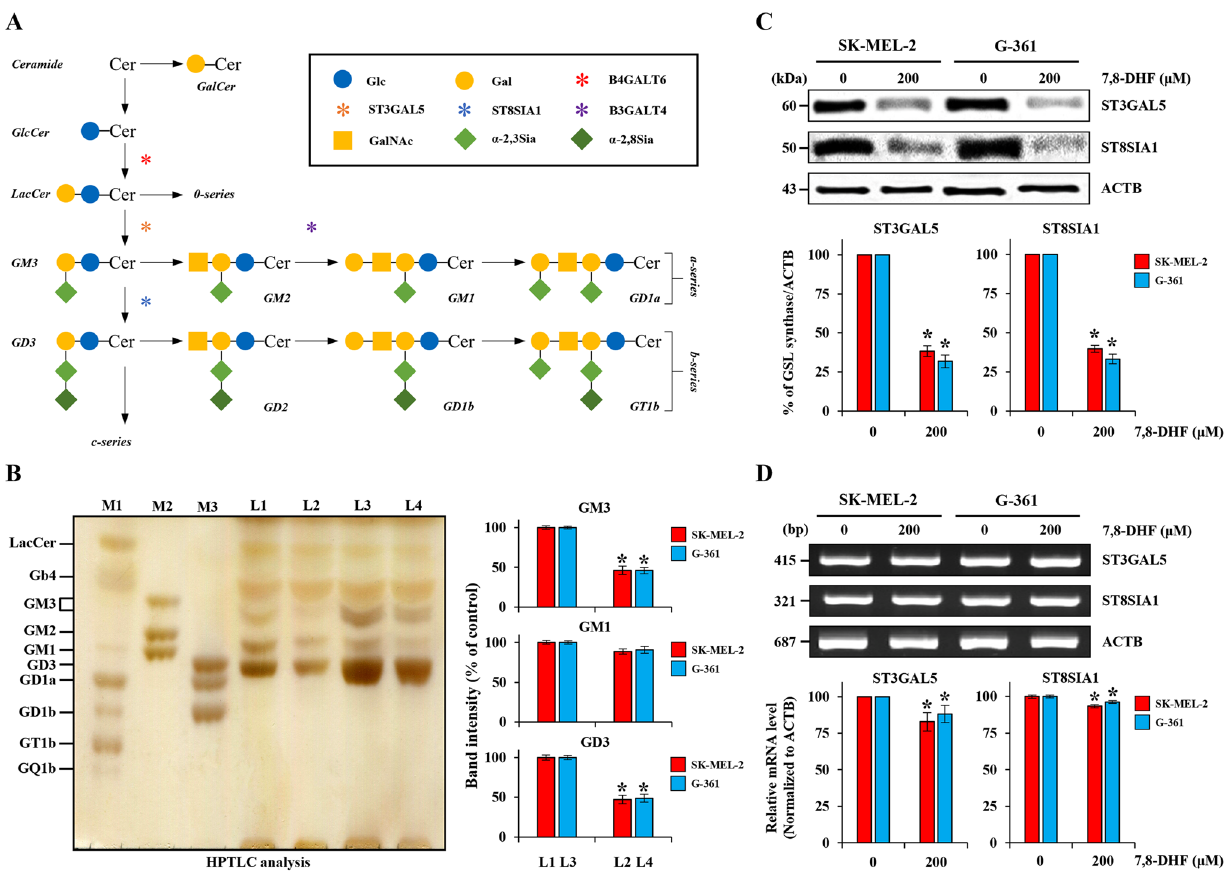
Fig. 6 Changes in ganglioside expression in 7,8-DHF treated SK-MEL-2 and G-361 melanoma cells. A Common ganglioside biosynthesis. G: ganglioside; M: monosialo; D: disialo; numbers denote carbohydrate sequence. GlcCer: glucosylceramide; LacCer: lactosylceramide; GalNAc: N-acetylgalactosamine; B4GALT6, beta-1,4-galactosyltransferase 6; ST3GAL5, ST3 beta-galactoside alpha-2,3-sialyltransferase 5; B3GALT4, beta-galactosyltransferase 4; ST8SIA1, ST8 alpha-N-acetylneuraminide alpha-2,8-sialyltransferase 1. B HPTLC analysis of gangliosides (10 µg/ µL) in untreated SK-MEL-2 cells (L1), SK-MEL-2 cells treated with 7,8-DHF (200 µM for 24 h) (L2), untreated G-361 cells (L3), and G-361 cells treated with 7,8-DHF (200 µM for 24 h) (L4). M, marker; L, line; M1 adult rat brain standard gangliosides; M2 and M3, ganglioside standard mixture marker (left panel); the quantification of band intensity for GM3, GM1, and GD3 in SK-MEL-2 and G-361 cells (right panel). Data rep- resent the mean ± SD ( n = 3, * p < 0.05). C Western blot analysis and D RT-PCR analysis of the gangliosides GM3 and GD3 synthase was exam- ined, respectively. Red square and blue square indicate SK-MEL-2 and G-361 cells, respectively. ACTB was used as a loading control. ACTB; β-actin. All data were presented as mean percentage levels ± SD ( n = 3, * p <